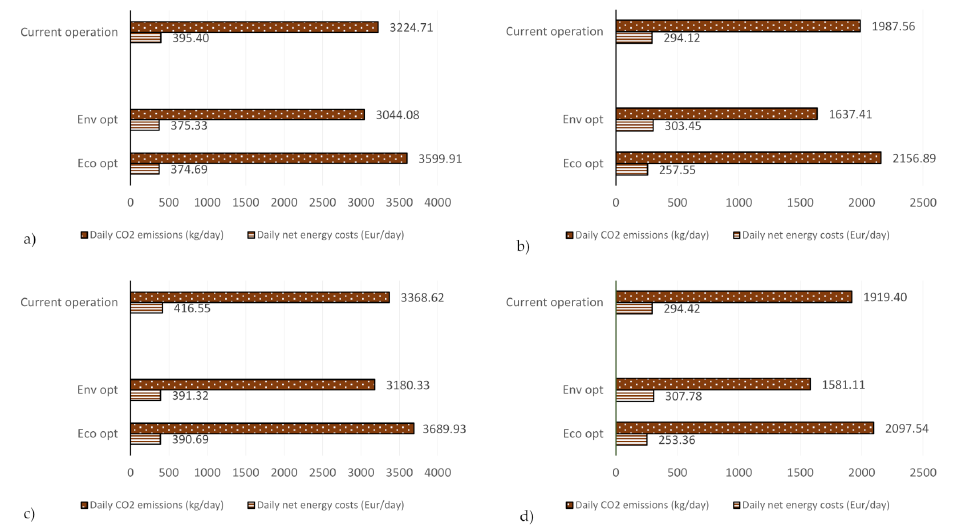
Figure 17. Comparison between the current case and the optimized case according to the environmen- tal and the economic objective for the Savona campus for: ( a ) stochastic approach for a representative winter day; ( b ) stochastic approach for representative summer day; ( c ) deterministic approach for 18 January 2018; ( d ) deterministic approach for 18 July